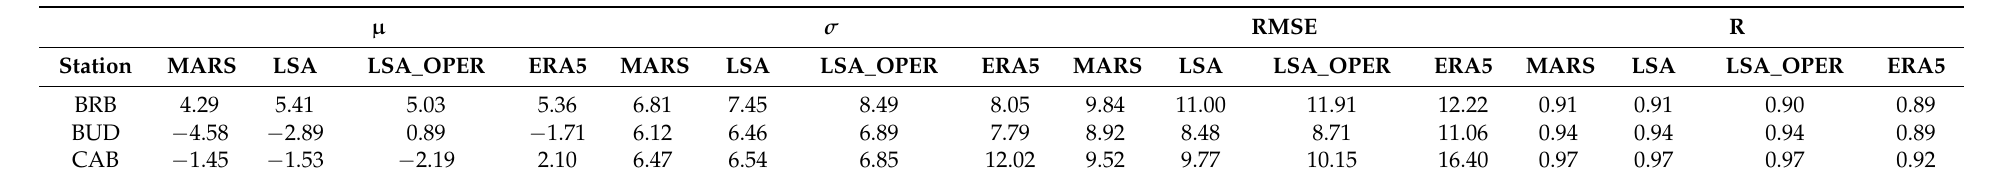
Table A6. Error metrics between model (MARS, LSA_OPER, LSA, and ERA5) and measuring station (clear-sky conditions) for 2004–2019. Bias ( µ ),